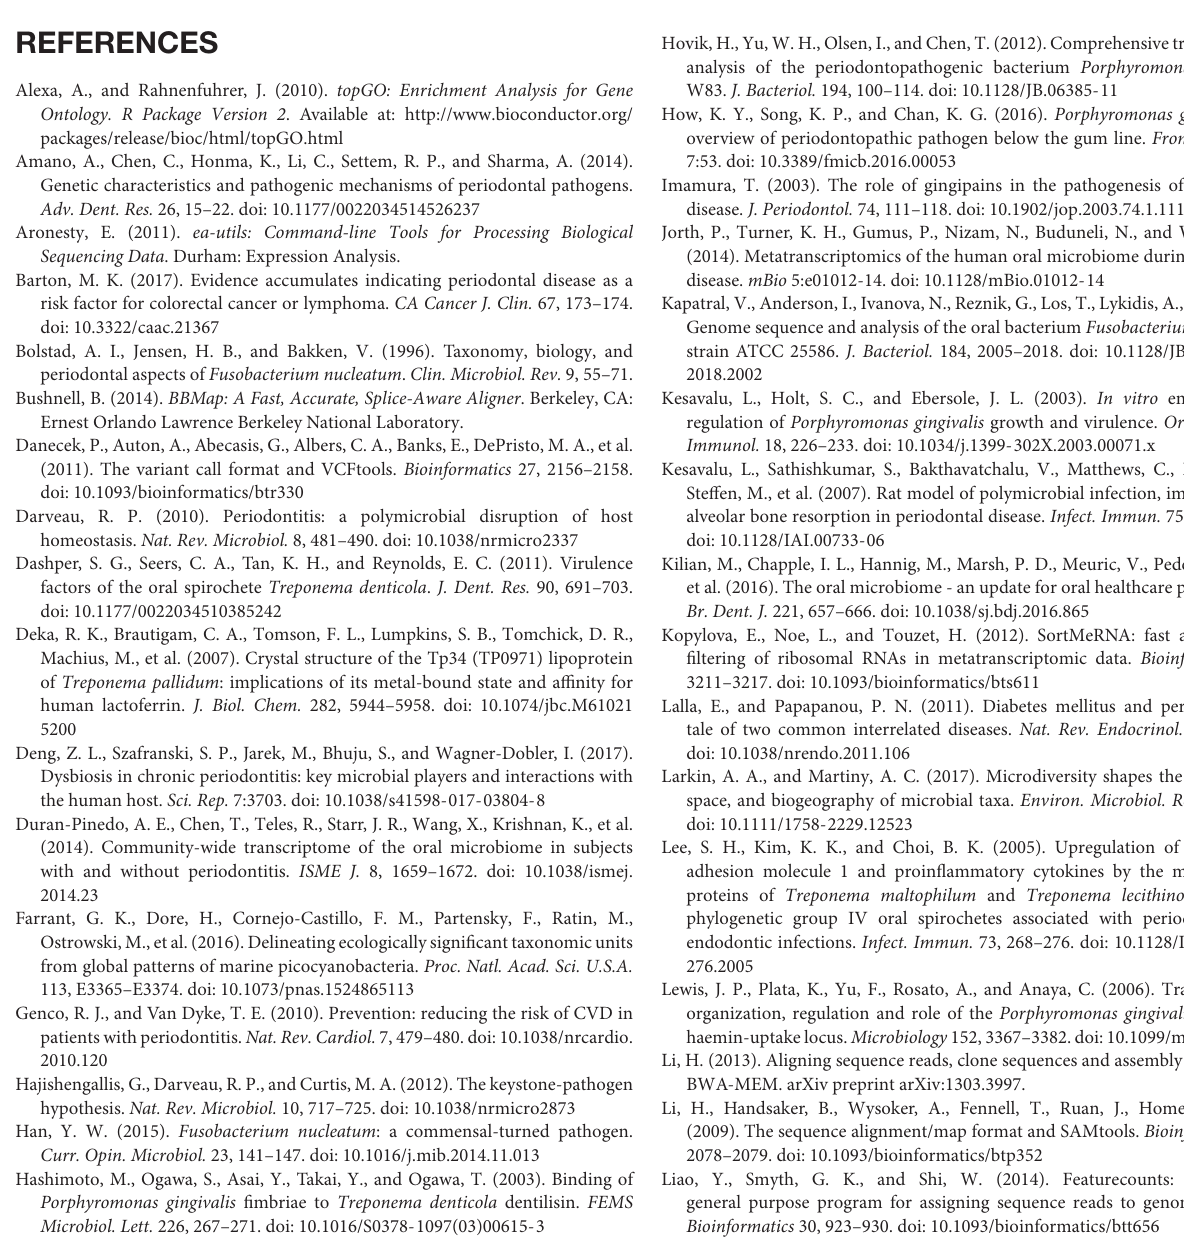
SHEET 6 | The gene expression of T. denticola in periodontal and mono-culture. SHEET 7 | The differential expression of T. denticola in periodontal niche vs. mono-culture. SHEET 8 | Gene ontology term enrichment analysis of T. denticola . SHEET 11 | The differential expression of F. nucleatum in health vs. mono-culture. SHEET 12 | The differential expression of F. nucleatum in periodontitis vs. health.